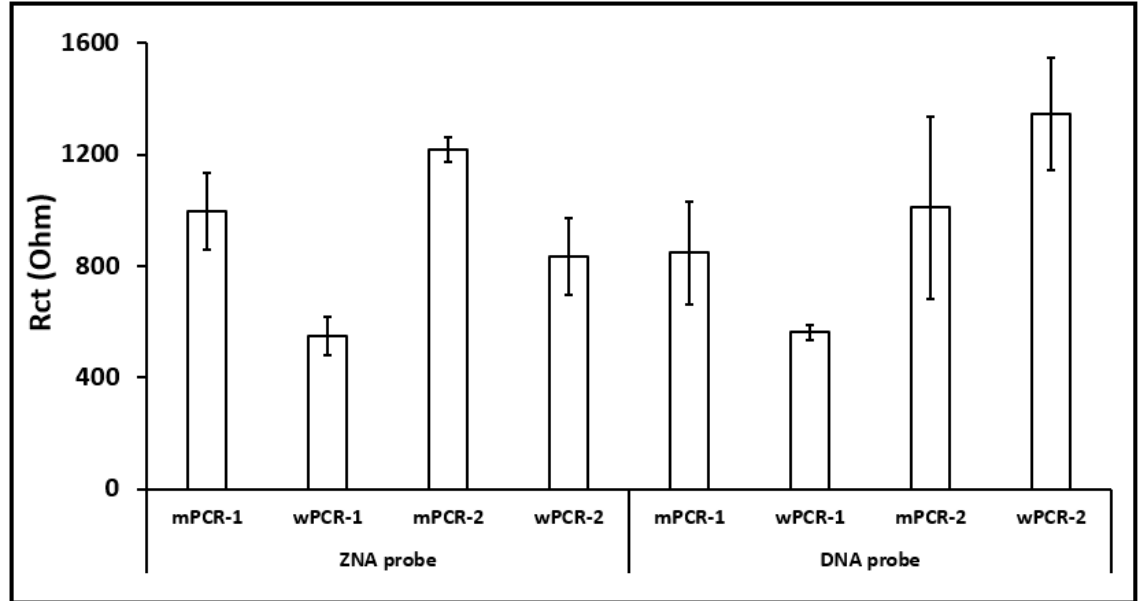
Figure 7. Histograms representing the average R ct values related to the hybridization of the ZNA probe or DNA probe with mPCR-1, mPCR-2, wPCR-1 or wPCR-2 ( n = 3).